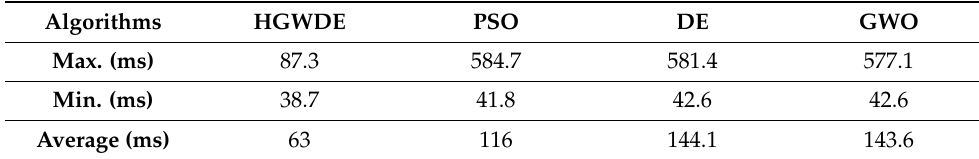
Table 3. Overview of response time for each algorithm.